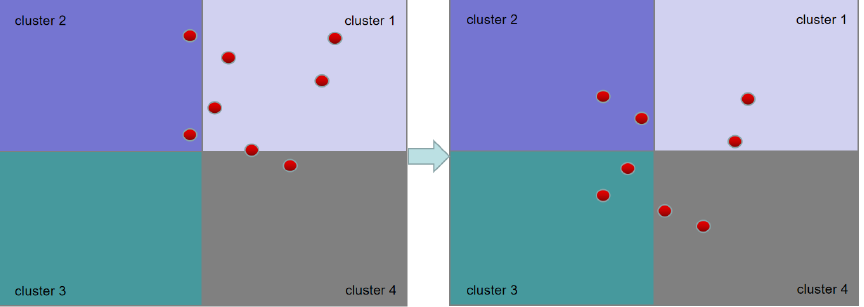
Figure 2. Left: most points are located in the first quadrant and thus are assigned into the cluster 1, while there are no points located in the third quadrant; right: Translating all points as a whole not only can prevent their relative distances, but also make them evenly distributed into the four